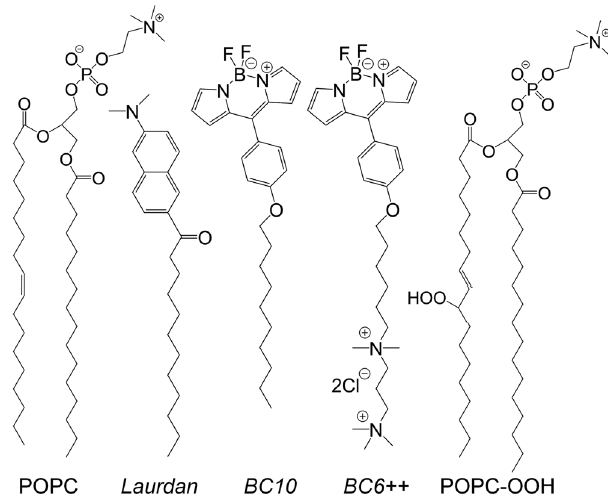
Fig. 1 Schematic of the lipid and dye structures used in this work. Peroxidation of POPC results in the addition of a peroxide group (-OOH) which locates at either 9 ’ or 10 ’ position (see ESI). Membrane order is measured using the dyes Laurdan, BC10 and BC6 + +